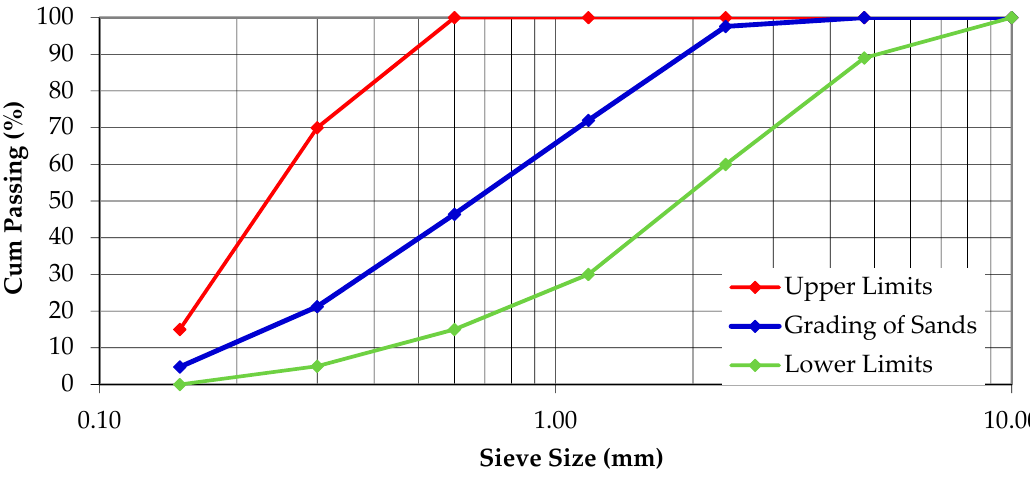
Figure 1. Particle size distribution of silica sand. Table 3. Chemical composition and physical properties.